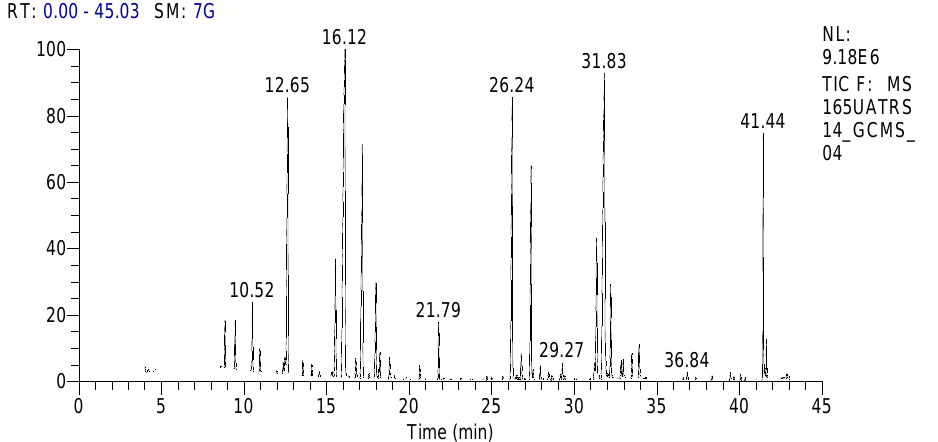
Figure 2. GC chromatography of SOEO at the beginning of the flowering stage.